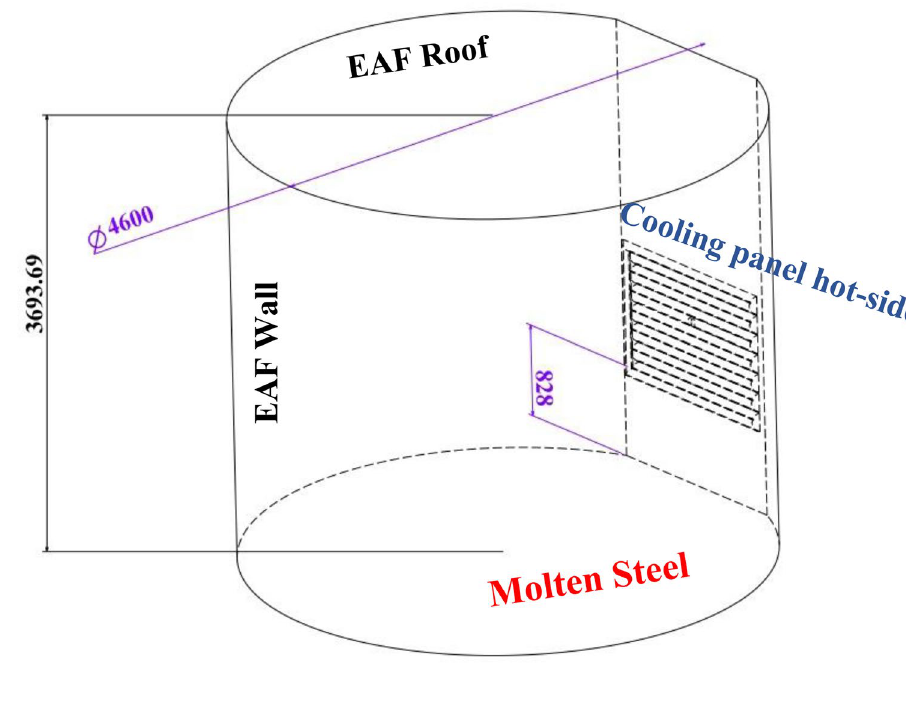
Fig. 3 Geometry of wall water cooling panel (WCP)